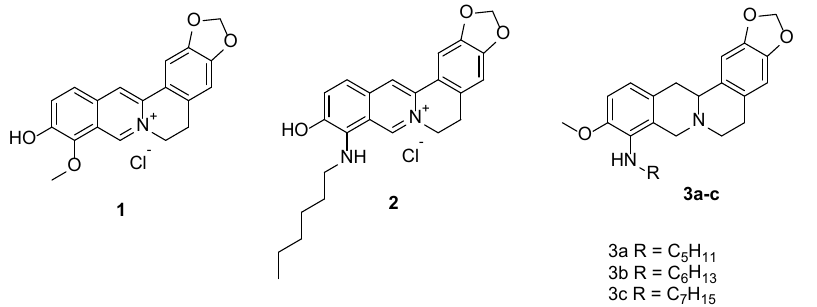
Figure 1. Structures of berberine 1 , 9-N-hexylberberine 2 , and 9-N-alkyltetrahydroberberines 3a – c .